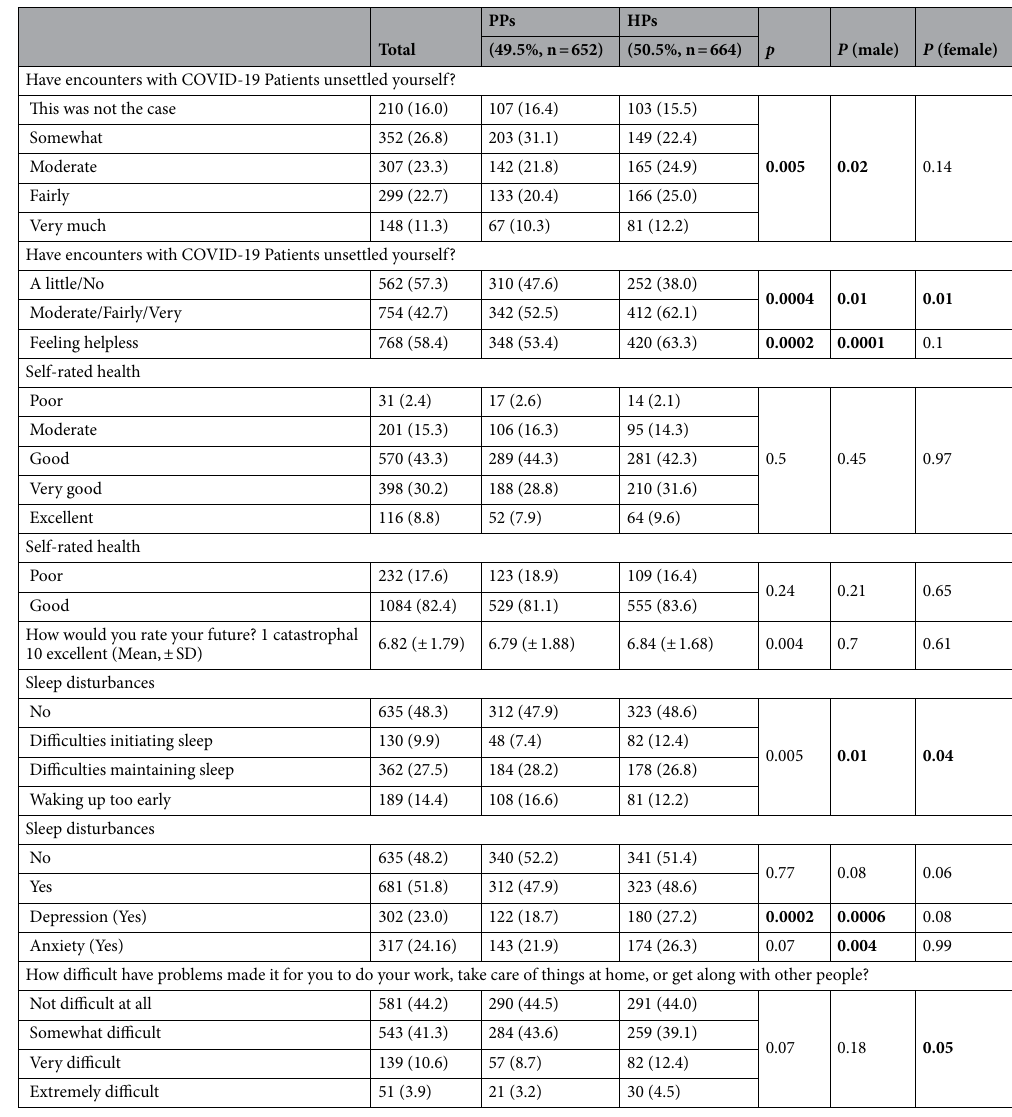
and HPs; p values obtained from chi-square-test for categorical variables and Wilcoxon–Mann–Whitney test for continuous variables. Significant values are in